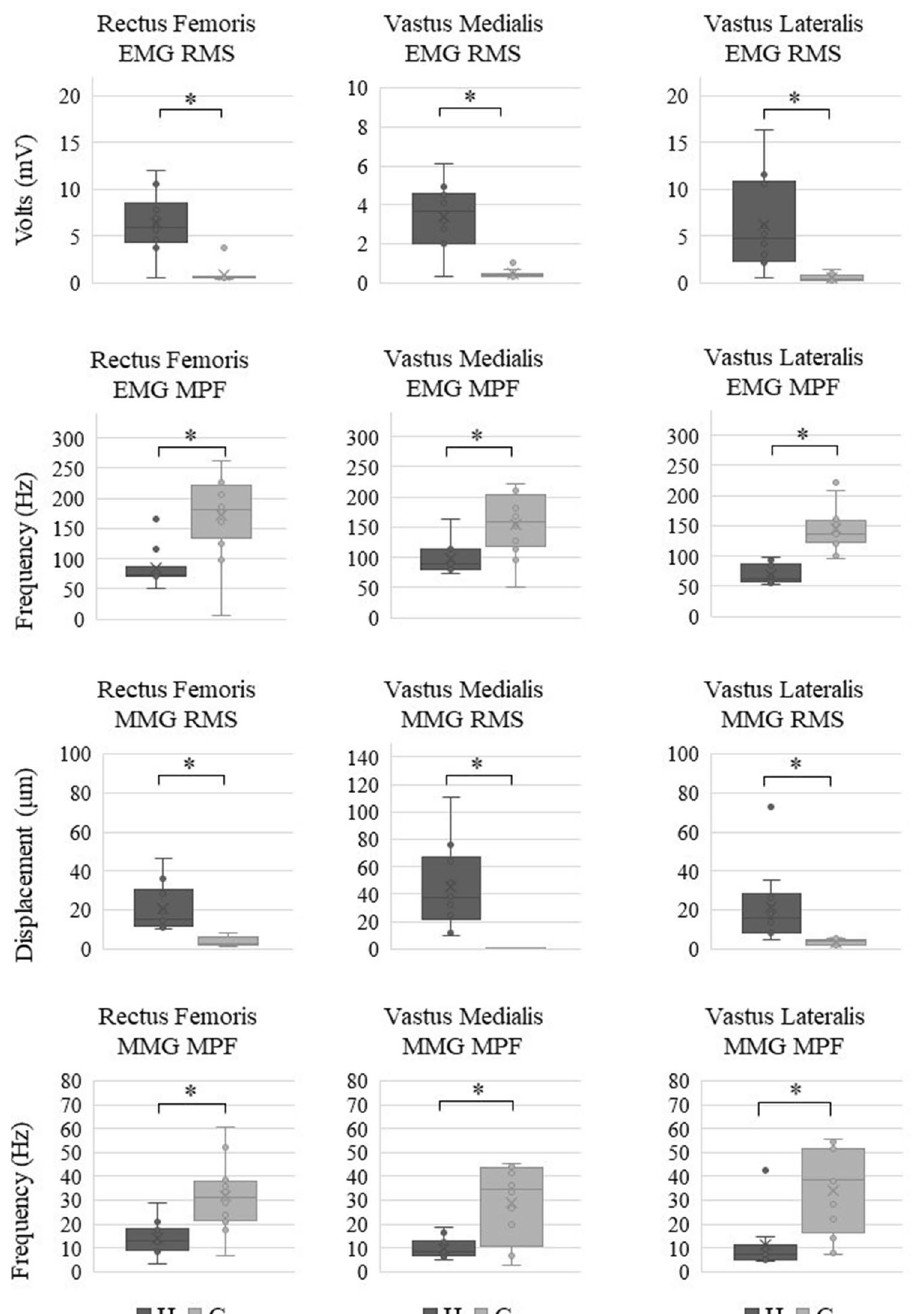
Figure 1. Differences between participants with hyperreflexia (H group) and control participants (C group) for EMG–RMS, EMG–MPF, MMG–RMS, and MMG–MPF with maximal force. The H group is shown on the left side, and the C group is shown on the right side of each graph. Standard deviation is shown as an error bar. The asterisk indicates p < 0.001. EMG: electromyography, RMS: root mean square, MMG: mechanomyography, MPF: mean power